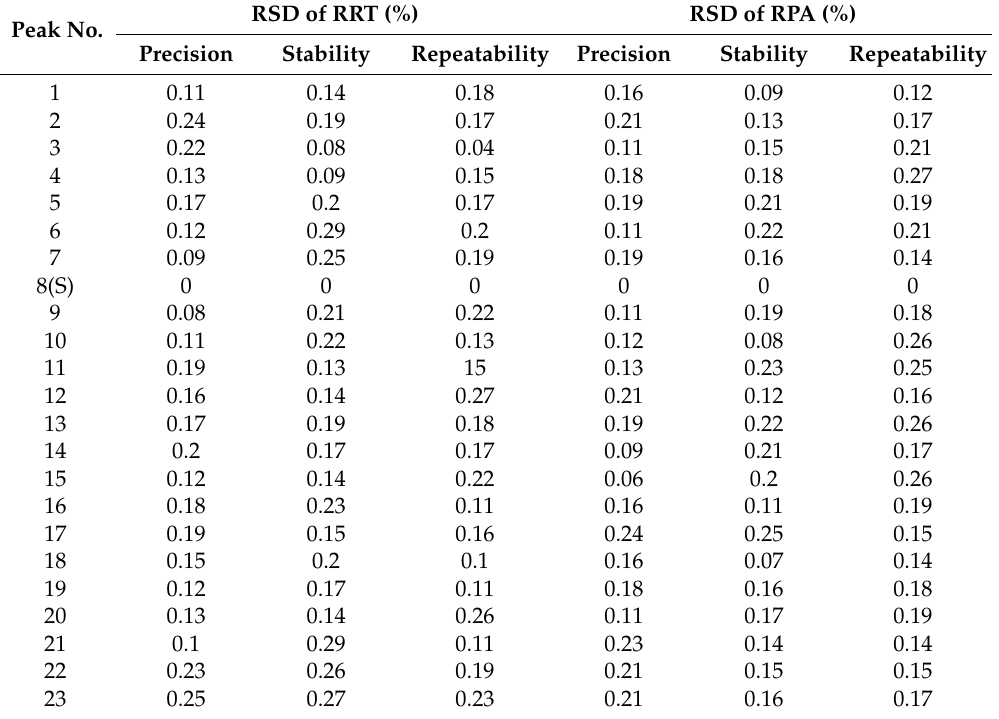
Table 2. Analytical results of precision, stability, and repeatability tests of 23 characteristic common peaks in R. rugosa samples (Sample 8) ( n = 5). RSD of RRT (%) RSD of RPA (%) Peak No. Precision Stability Repeatability Precision